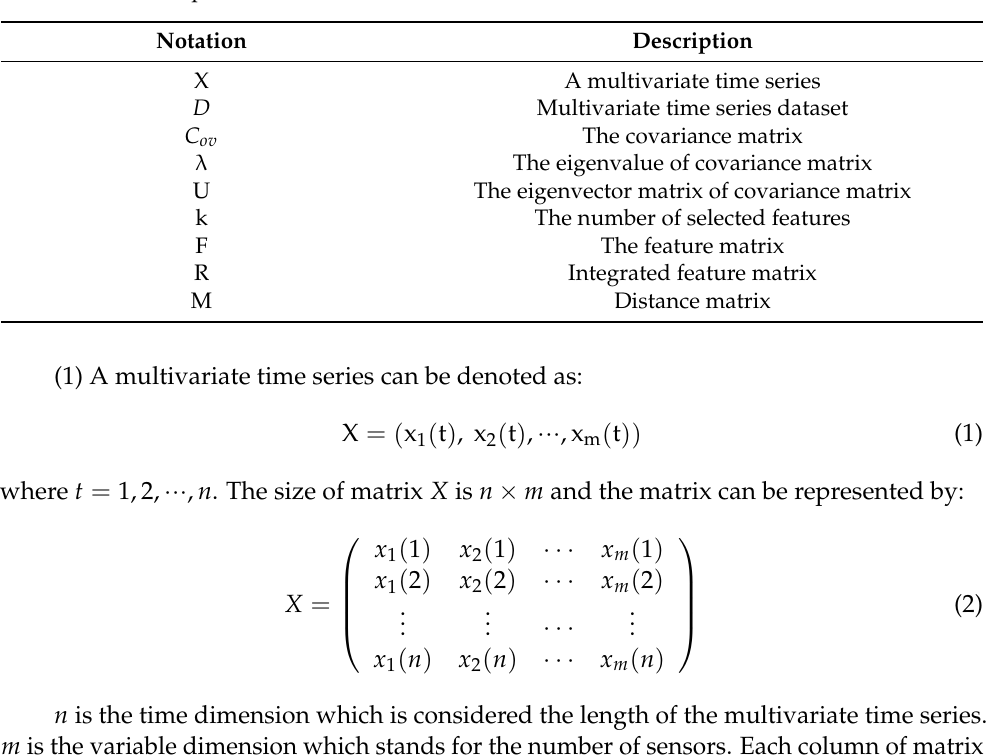
Table 1. The Description of the